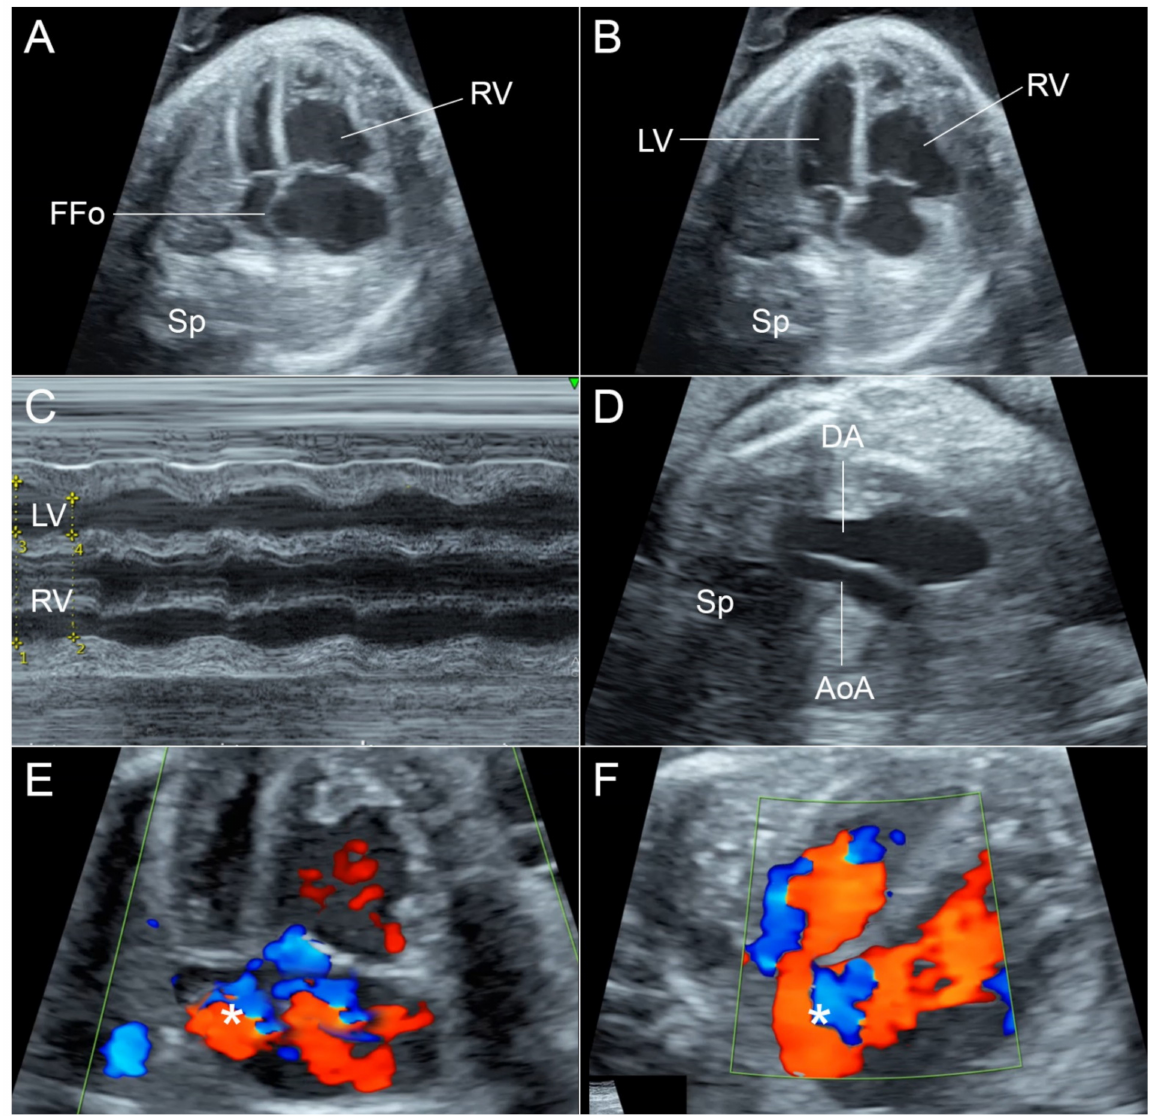
Figure 1. ( A , B ) Four-chamber views show left/right size disproportion and the size of RV is nearly the same during systole ( A ) and diastole ( B ), indicating poor contraction. The FFo is fixed and tense bulging during systole and diastole. ( C ) M-mode shows poor shortening fraction of RV, when compared with the LV. ( D ) Three-vessels and trachea view shows the much smaller AoA, compared with DA. ( E , F ) Color flow shows turbulent flow (*) in FFO and blood partially crosses to the left side ( F ). (AoA: aortic arch; DA: ductus arteriosus; FFo: flap of foramen ovale; LV: left ventricle; RV: right ventricle; Sp: